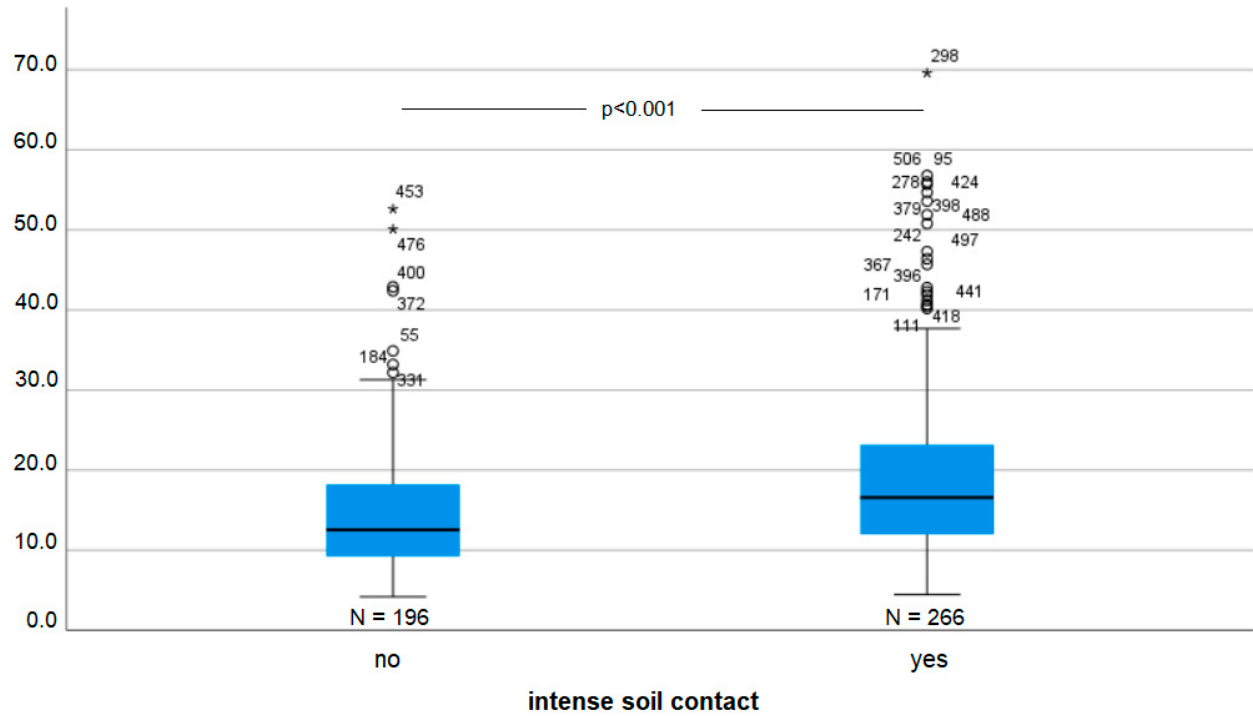
Figure 4. BLL and intense soil contact p = 0.035. Outliers marked with * are values above the third quartile plus 1.5 times the interquartile range. The age of the real estate is given as a boxplot in Figure 5.